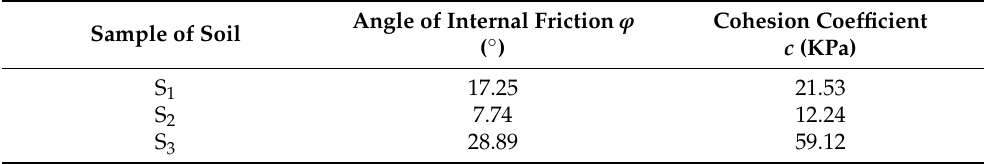
Table 2. Cohesion coefficient and angle of internal friction of loess.